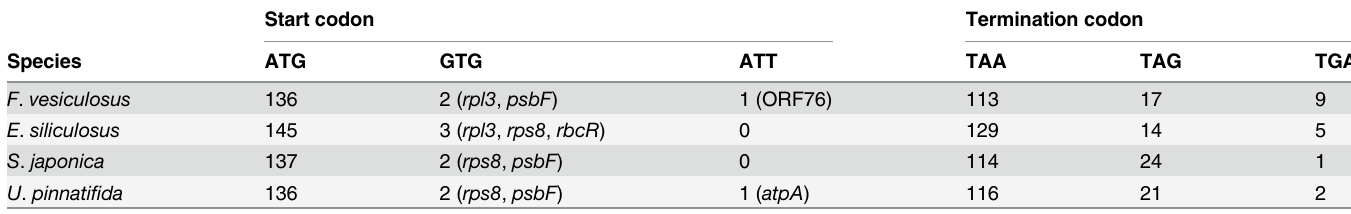
Table 1. Comparison of codon usage of four large brown algal plastid